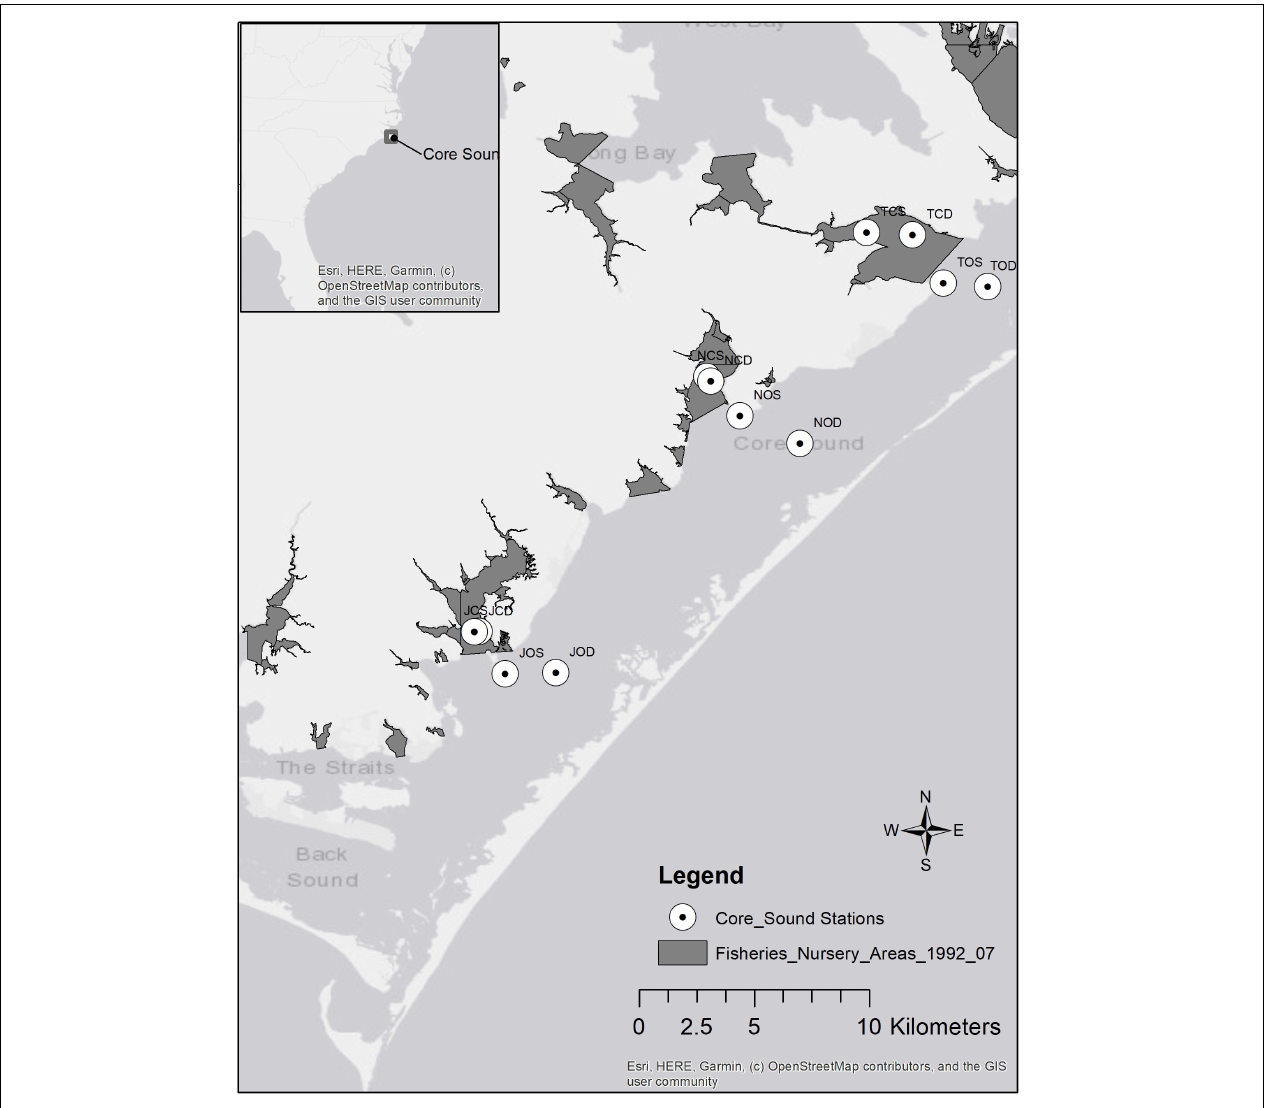
FIGURE 2 | Map of Core Sound study area (inset shows location in North Carolina, United States). No trawling zones (Primary and Secondary Nursery Areas) established in 1978 and enforced by NCDMF are shown as dark gray areas. Sampling stations for ECOPATH model are indicated by open